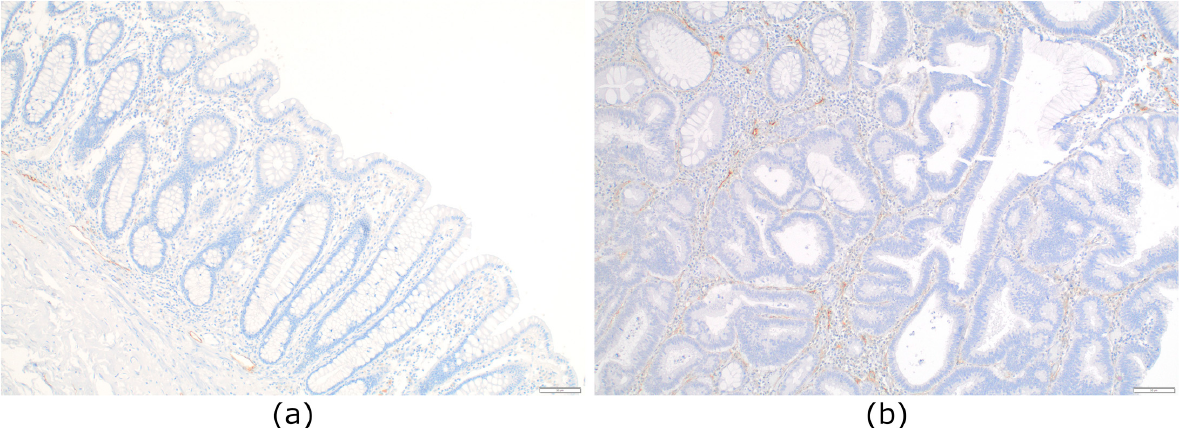
Figure 1. Distribution of lymphatic vessels in normal colon mucosa and in situ colorectal carcinoma: ( a ) Normal colonic mucosa devoid of lymphatic vessels in the lamina propria. Lymphatic vessels are seen just above the muscularis mucosae and in the submucosa (D2-40, ×100); ( b ) lymphatic vessels present in the lamina propria of a pTis colorectal carcinoma (D2-40, ×100).